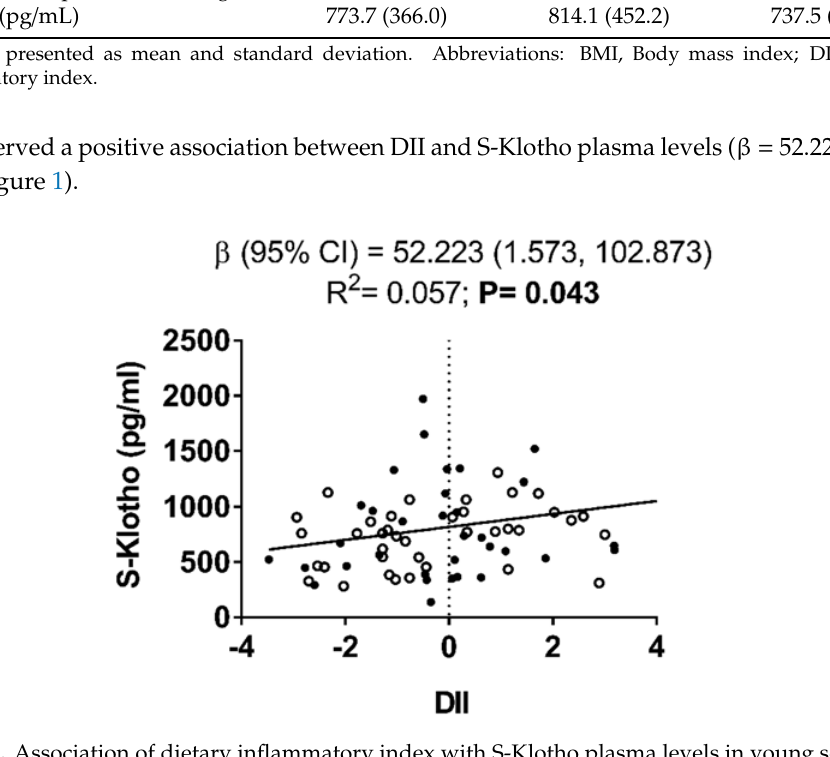
Figure 1. Association of dietary inflammatory index with S ‐ Klotho plasma levels in young sedentary adults. Non ‐ standardized β coefficient [95% confidence interval], R 2 and p value are provided. Black and white dots represent men and women and white dots represent men and women respectively.